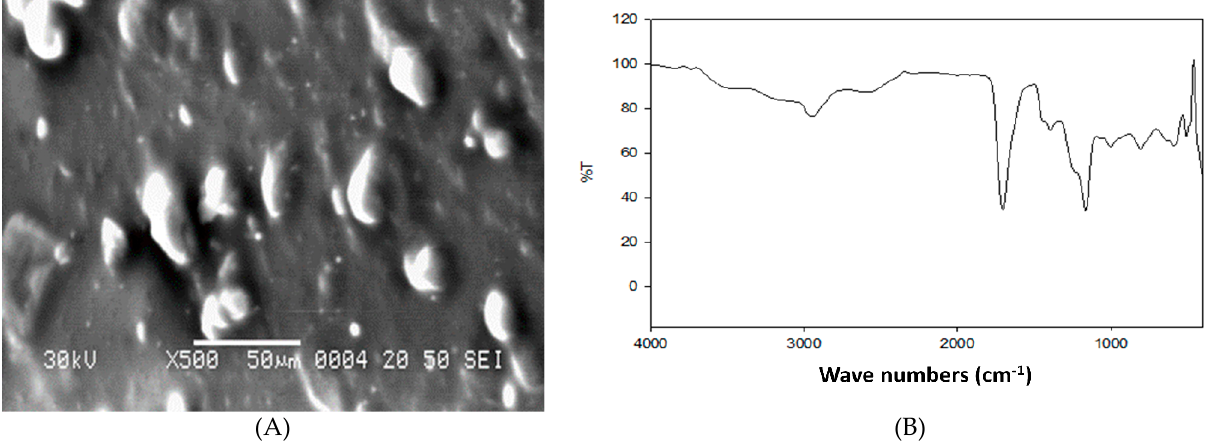
Figure 1. Scanning electron microscopy ( A ) and Fourier-transform infrared spectroscopy (FTIR, B ) of garlic nano-hydrogel (G-NHG).